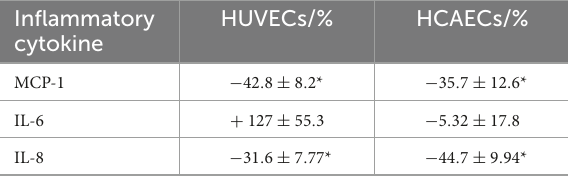
TABLE 1 Inhibition of Wnt/ β -catenin suppressed TNF- α -induced MCP-1 and IL-8 secretion, but not IL-6. Inflammatory